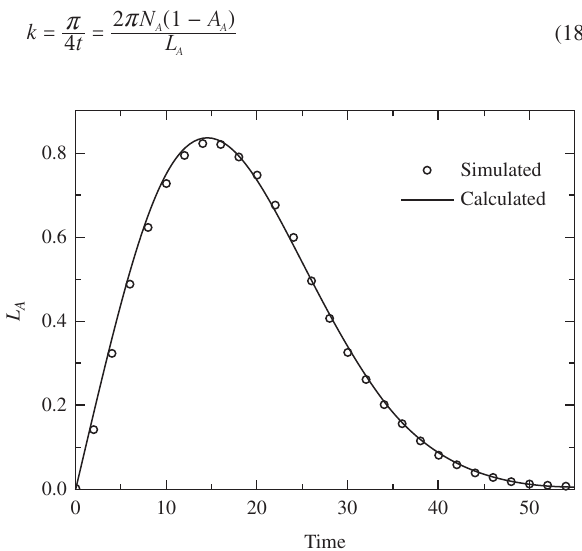
Figure 2. Length of the interface between transformed and untransformed region per unit of area, L , against time. Simulation results are in agreement A with those calculated from the kinetics of a single grain, Equation 13.